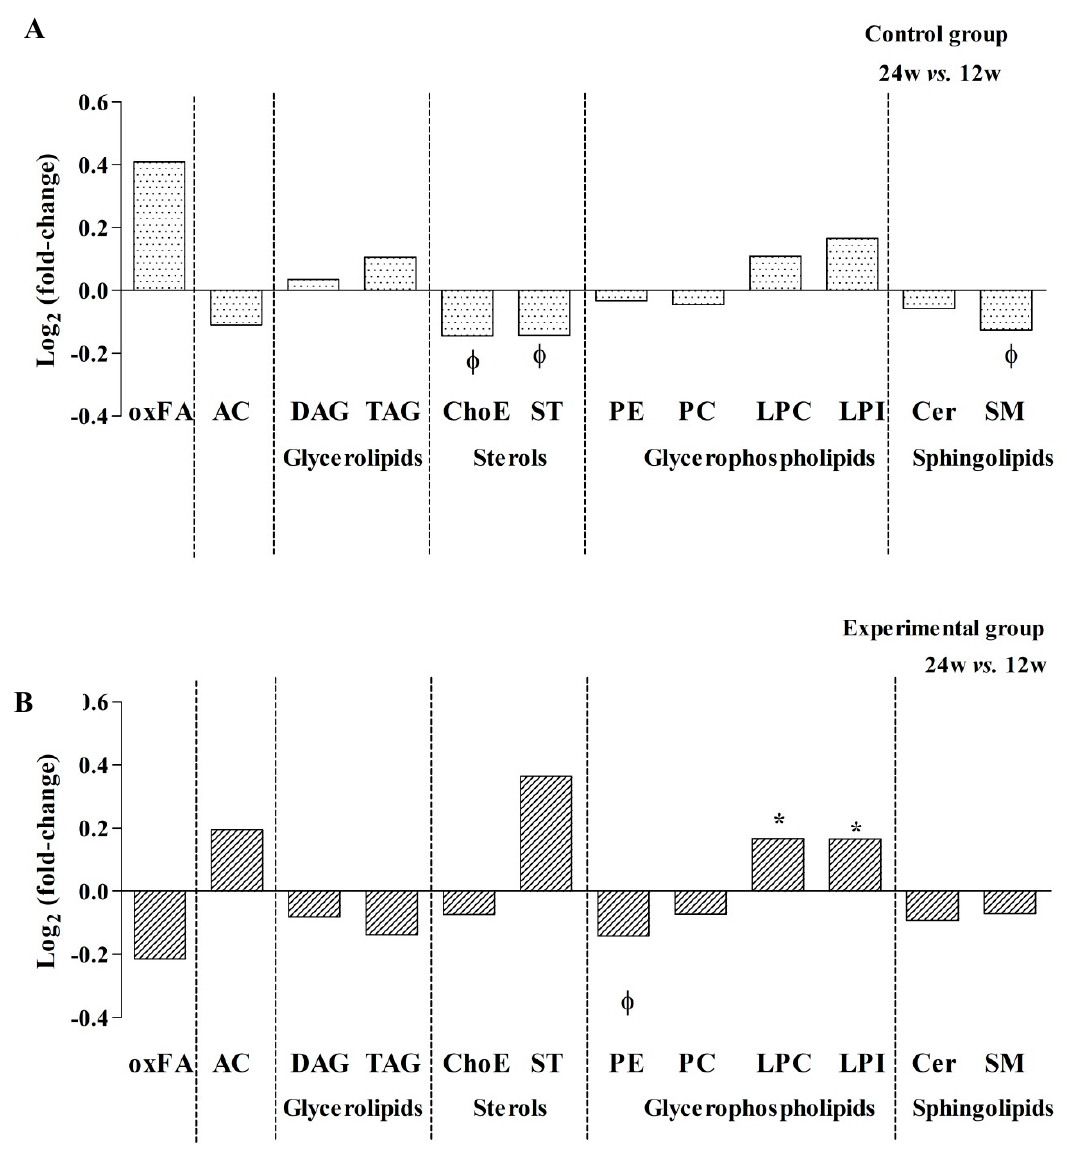
Figure 4. Effect of EFV and RPV on lipid metabolism. ( A ) Relevant metabolite changes grouped by chemical classes related to EFV or ( B ) RPV regimen. Data are expressed as log 2 (fold change) and values between 24 and 12 weeks were compared using paired Student’s t-test p -values. * p values < 0.05 were considered significant and ϕ p values > 0.05 but < 0.10 were considered relevant in the